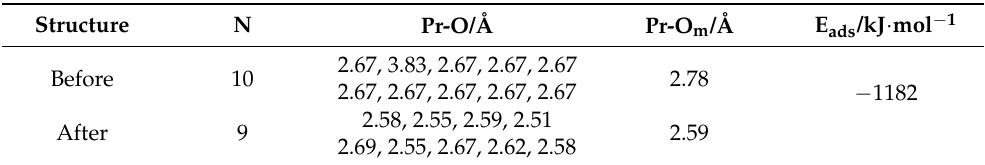
Figure 3. Equilibrium geometry of [Pr(H 2 O) 10 ] 3+ adsorbed on the (001) surface of Mt. The adsorption energy and structural parameters of [Pr(H 2 O) 10 ] 3+ adsorbed on the (001) surface are listed in Table 3. The number of H 2 O ligands of the Pr atom is reduced from 10 to 9, and the average length of the Pr–O bond is reduced from 2.78 Å to 2.59 Å after the adsorption. The adsorption energy is − 1182 kJ/mol, indicating that the adsorption of [Pr(H 2 O) 10 ] 3+ on the (001) surface of Mt is a spontaneous exothermic process. The adsorption energy is significantly lower than the values reported by other scholars on the Si–O surface of kaolinite ( − 473.37 kJ/mol) [24], suggesting that the adsorption stability of RE ions on the surface of Mt is significantly higher than that on kaolinite. This is consistent with a previous study [12], showing that it is more difficult to desorb RE ions from Mt than from kaolinite. Table 3. Adsorption energy and structural parameters of [Pr(H 2 O) 10 ] 3+ adsorbed on the (001) surface of Mt.